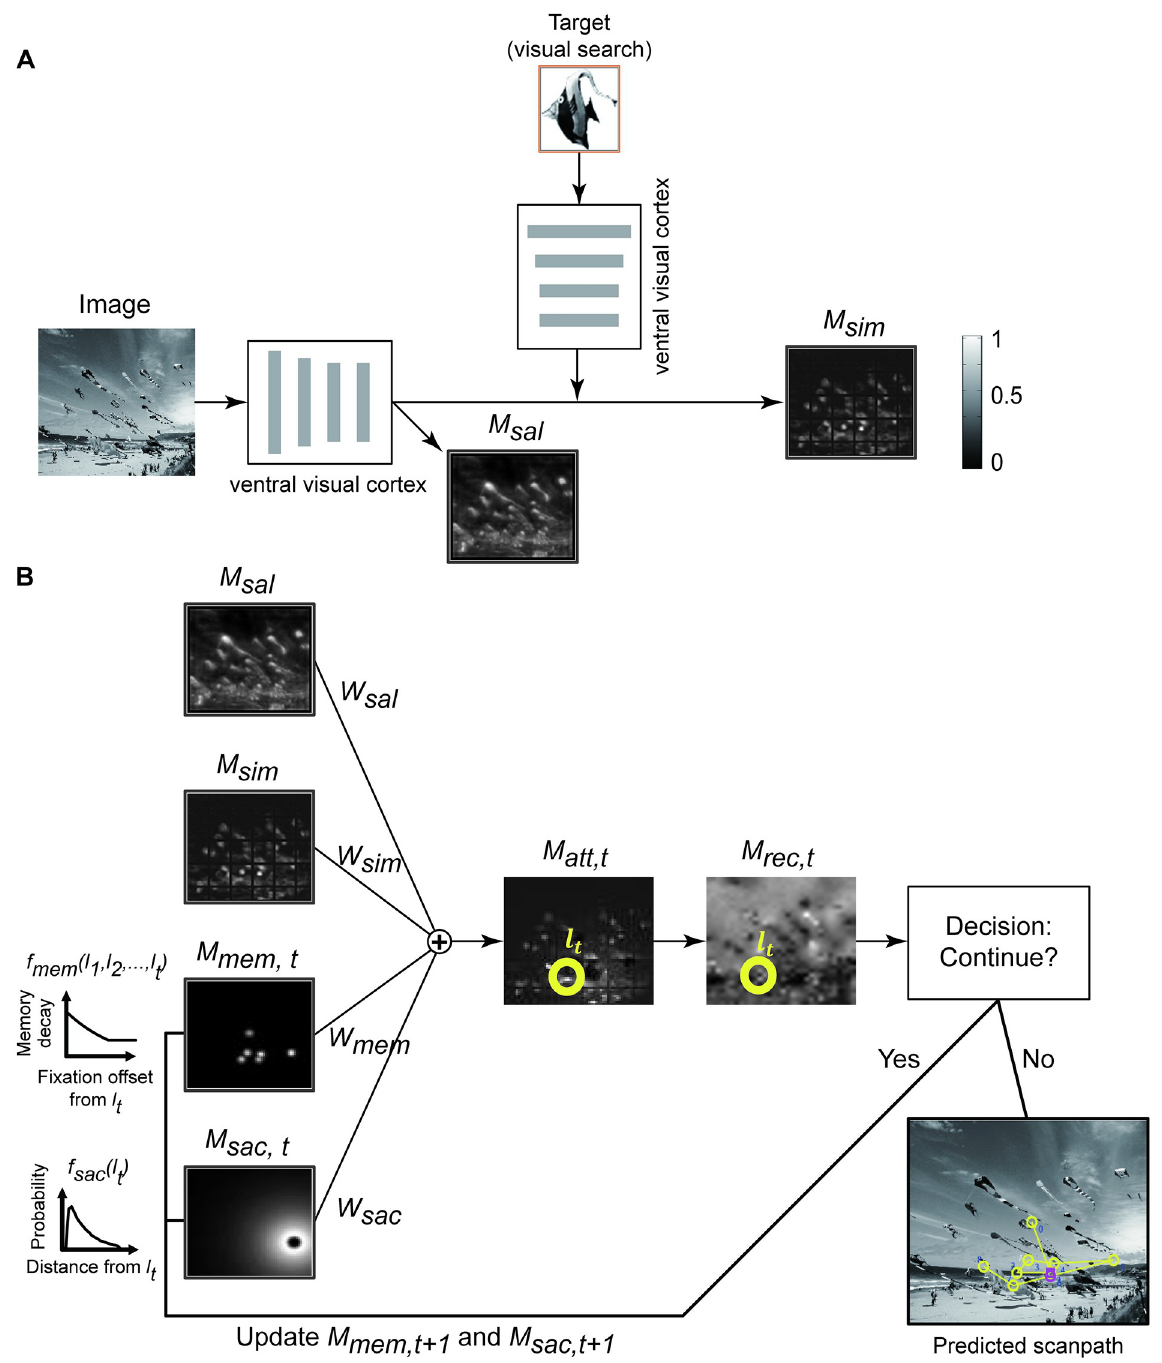
Fig 7. Architecture of the computational model. ( A ) The model has a ventral visual cortex module (pre-trained VGG-16) that extracts features from the image. These features constitute the saliency map ( M sal ). In visual search tasks, the same ventral visual cortex module processes the target image and modulates the features in the search image via top-down modulation, generating a target similarity map ( M and Methods for detailed architecture. ( B ) The generation of eye movements is governed by a weighted combination of 4 maps: M sal (part A ), M sim (part A , only in visual search tasks), a time-dependent memory map ( M mem , t , and a time-dependent saccade size constrain map ( M sac , t ). At each time point t , the 2D spatial memory decay map M mem , t is updated based on all previous visited locations f l color on the memory decay map, the stronger the effect of memory inhibition. The saccade size constrain map is also updated at each time point according to the current fixation location, l . A winner-take-all chooses the maximum in the combined attention map M t location for the next fixation. In visual search tasks, the model computes a recognition map M recog indicating the confidence that the current